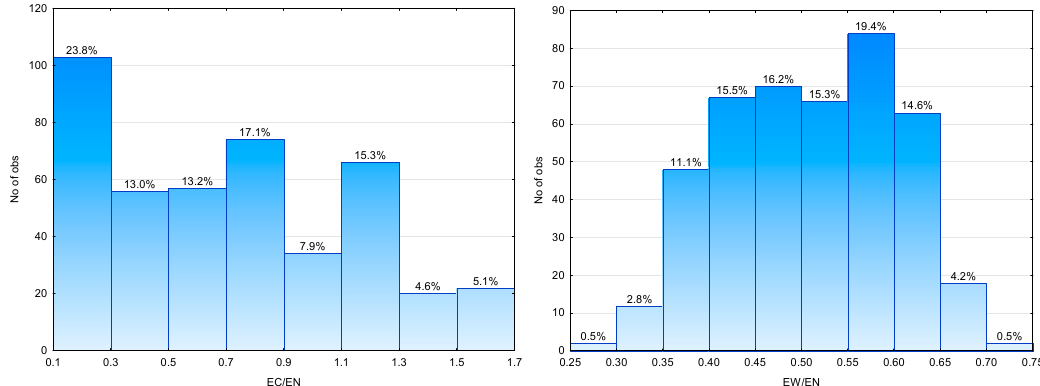
Figure 3. Histogram of uniformity UN for the analyzed cases. Energies 2020 , 13 , x FOR PEER REVIEW